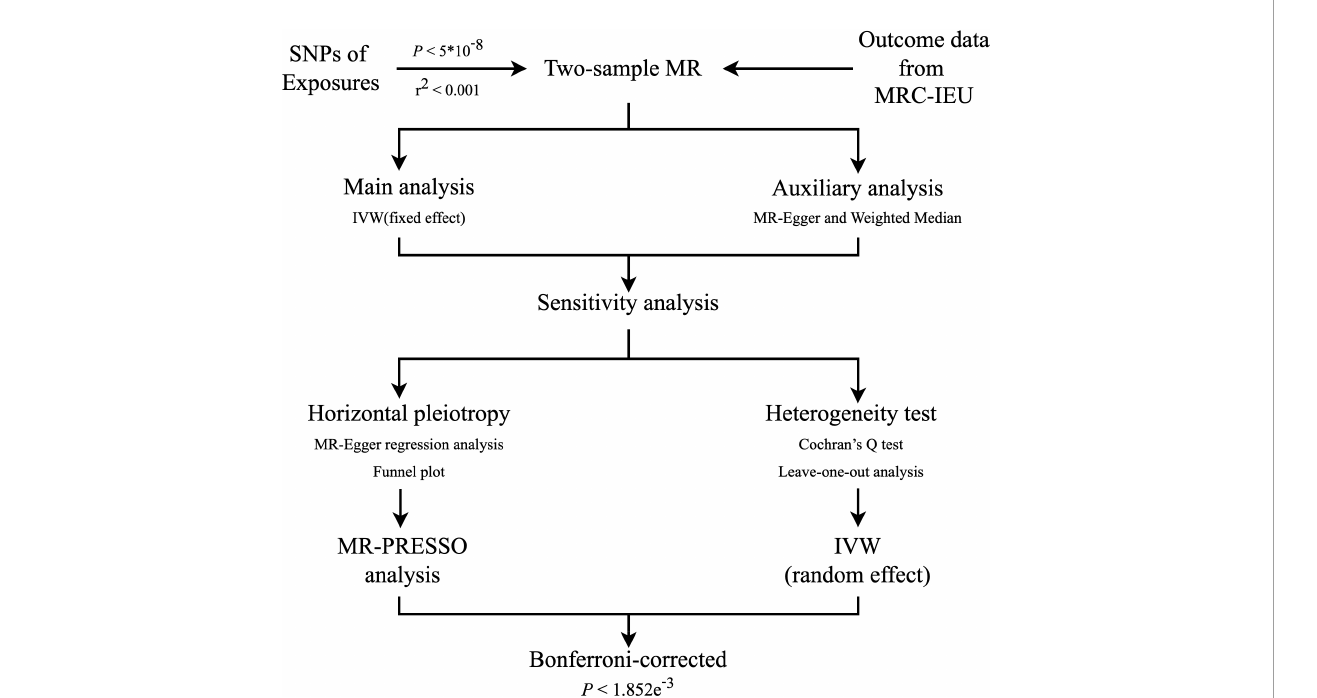
FIGURE 2 Flowchart of the statistical analyses, outlining the different analyses performed at each stage of the study. SNP, single-nucleotide polymorphism; MR, Mendelian randomization; MRC-IEU, MRC Integrative Epidemiology Unit; IVW, inverse ‐ variance